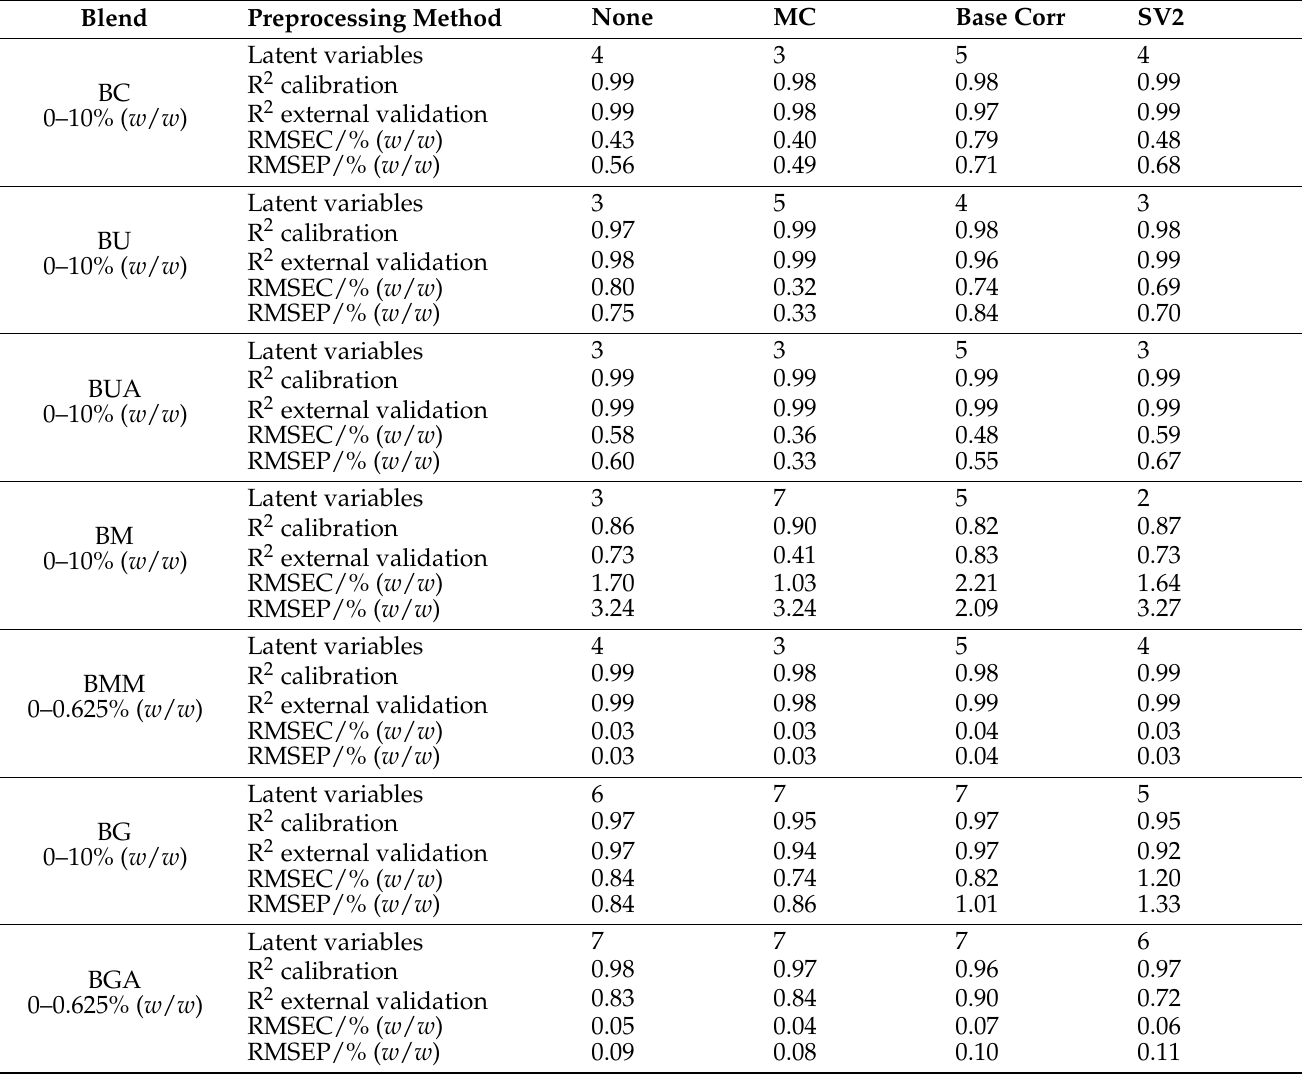
Table 4. PLS models based on FT-NIR spectra per BX blend, according to the concentration range of each contaminant and preprocessing method.